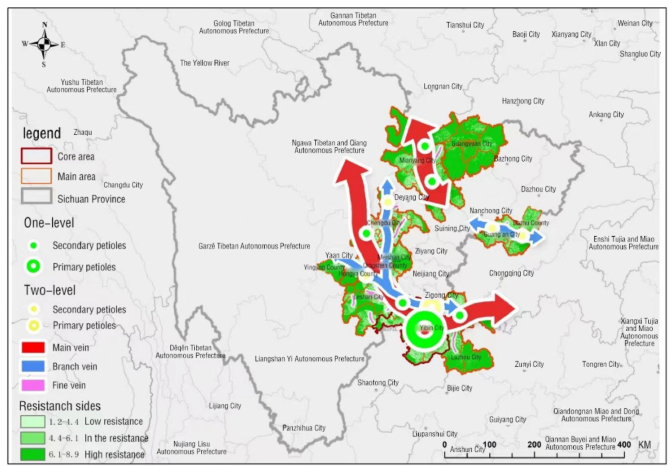
Figure 28. Suitability layout of research areas in Sichuan